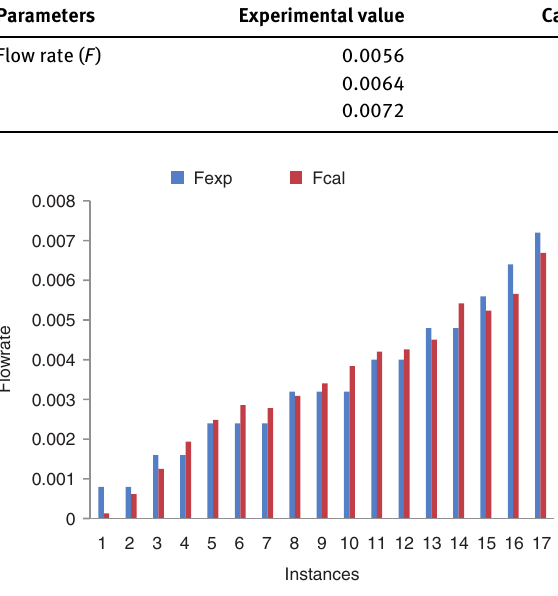
Figure 4: Calculated Flow Rate vs. Experimental Flow Rate.